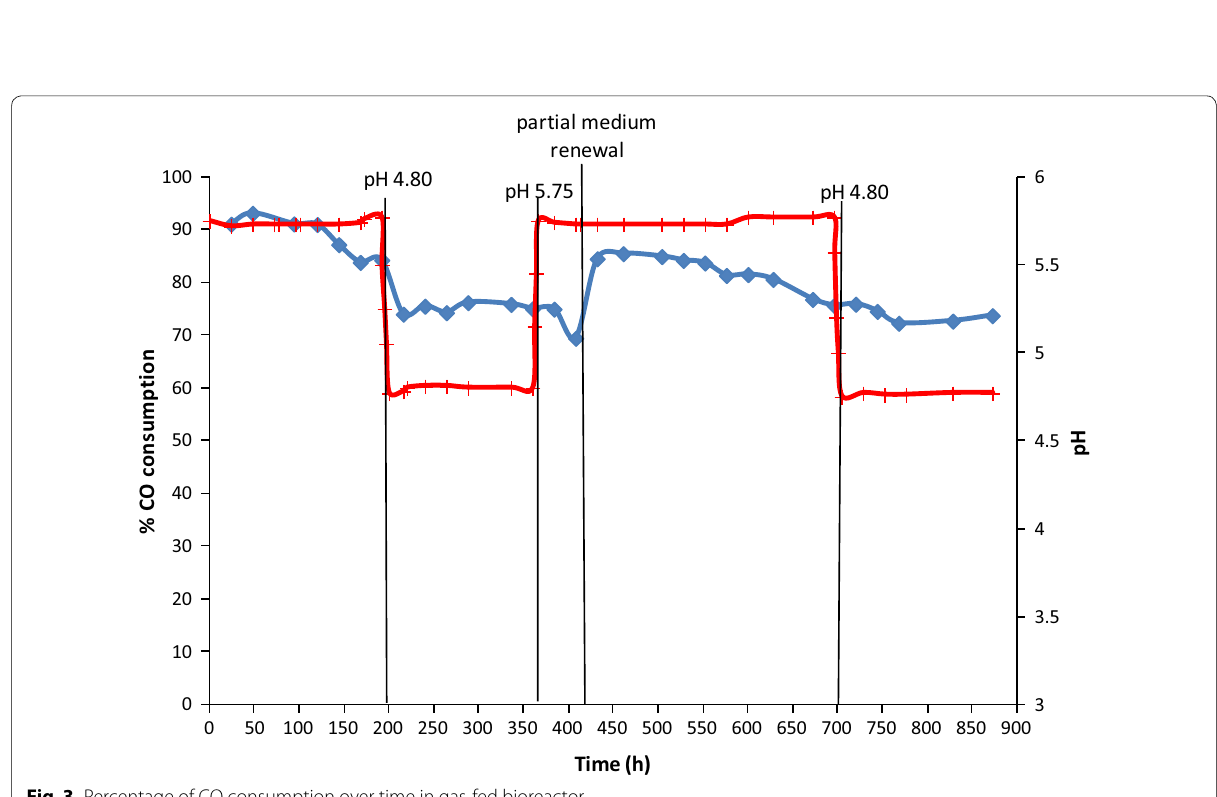
Fig. 3 Percentage of CO consumption over time in gas‑fed